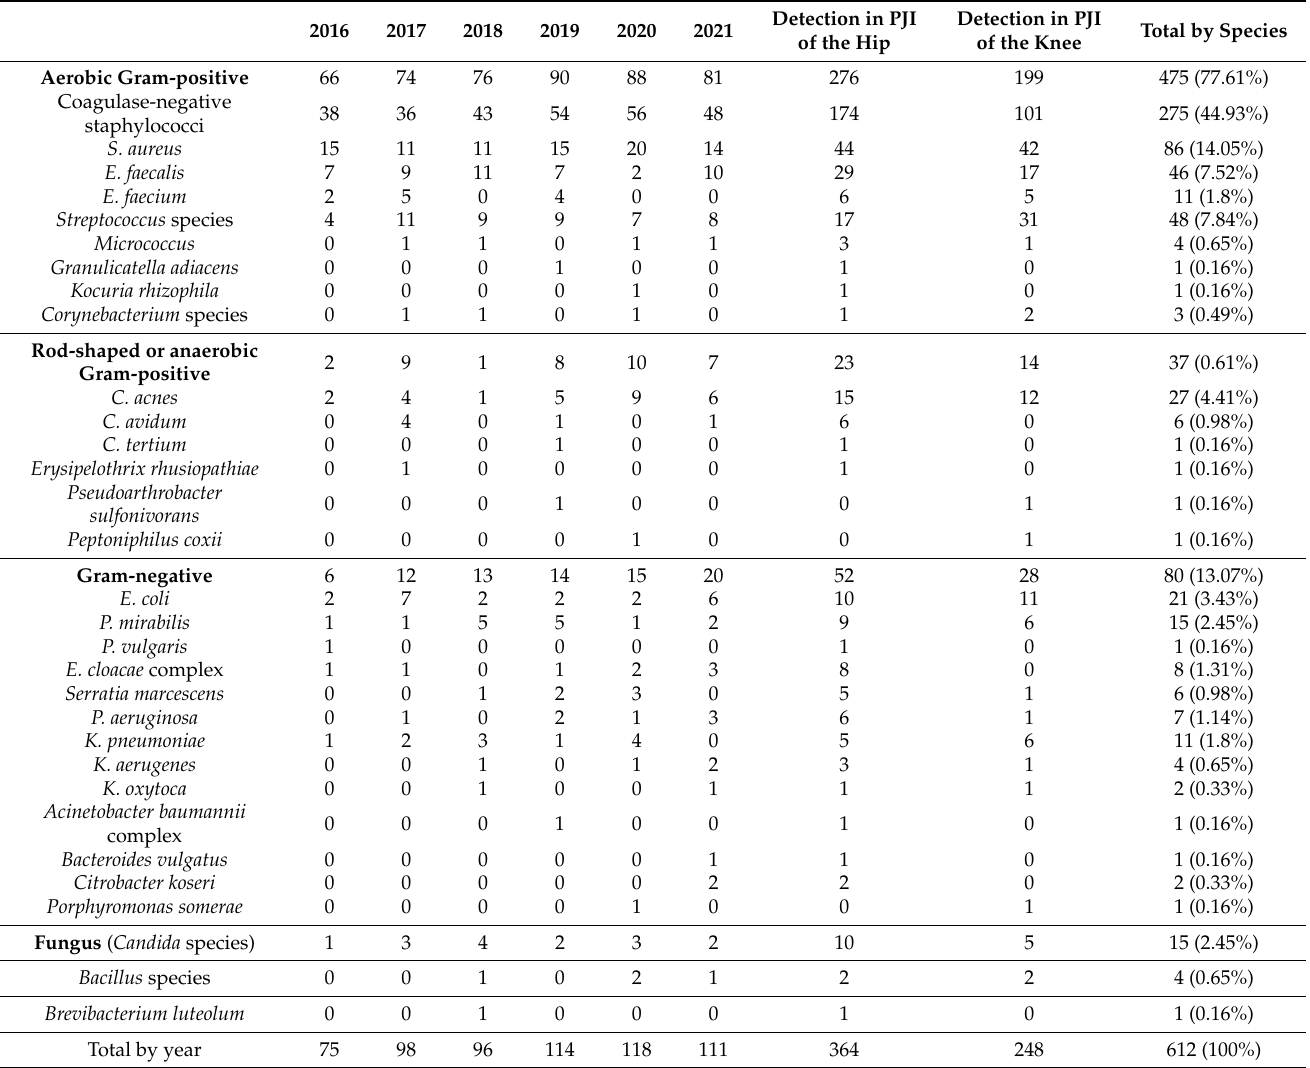
Table 2. Culture data over a six-year period by